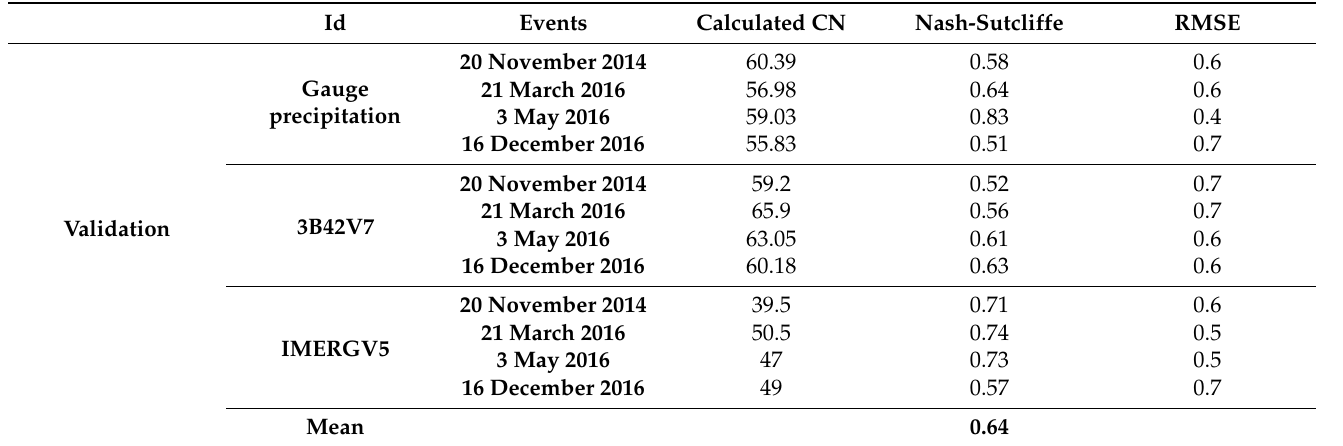
Table 6. Episodes validation results.